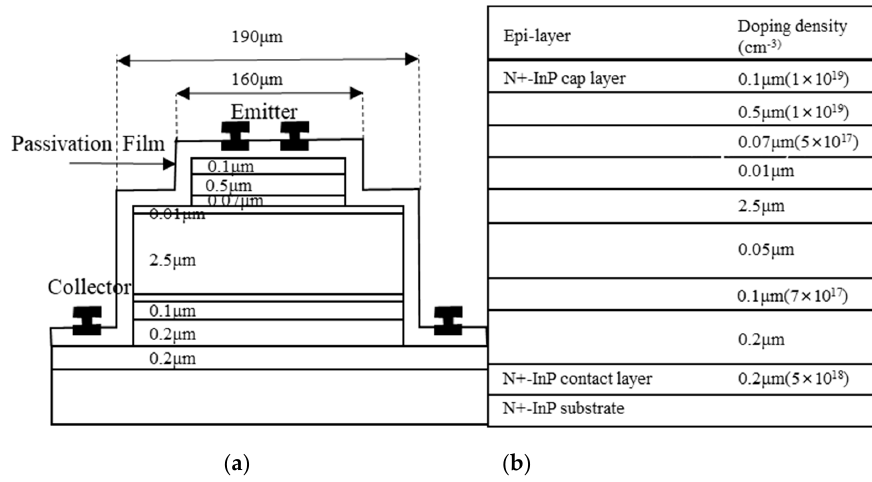
Figure 48. ( a ) The cross-section schematic diagram of APTs and structure profiles, ( b ) bandwidth and response time curves as a function of gain